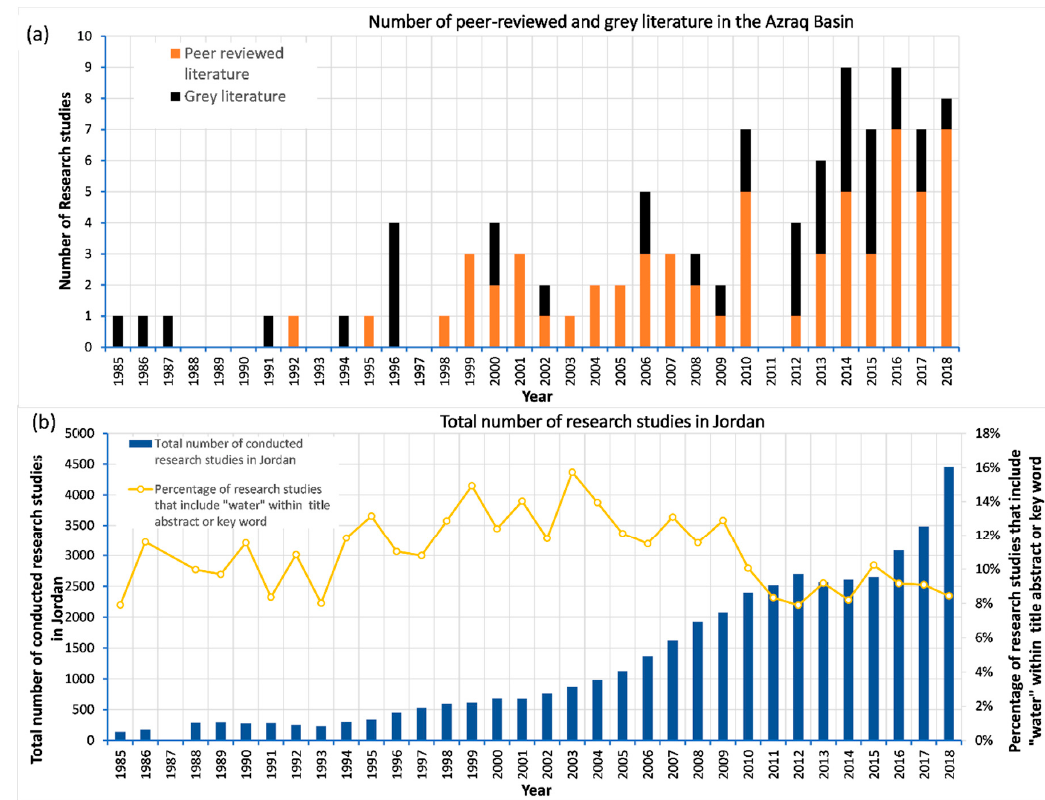
Figure 3. ( a ) Number of grey and peer-reviewed literature spanning the period (1985–2020). ( b ) Total number of documents that exist in the Scopus database produced by Jordanian institutions (blue column), percentage of number of documents stating the word “water” in the body of the document (orange line), percentage of number of documents stating the word “water” in a title, abstract or keyword of the document (grey line).